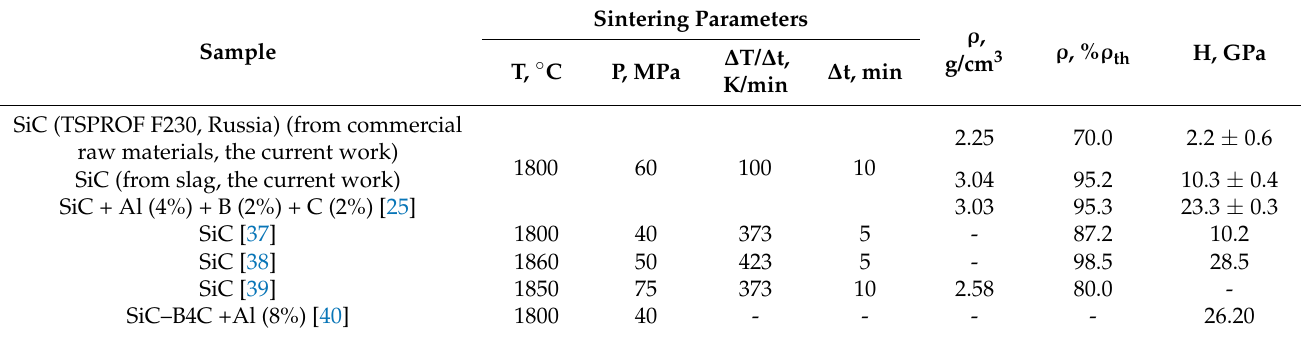
Table 2. Sintering parameters and results for commercial silicon carbide and for that obtained through slag plasma utilization.